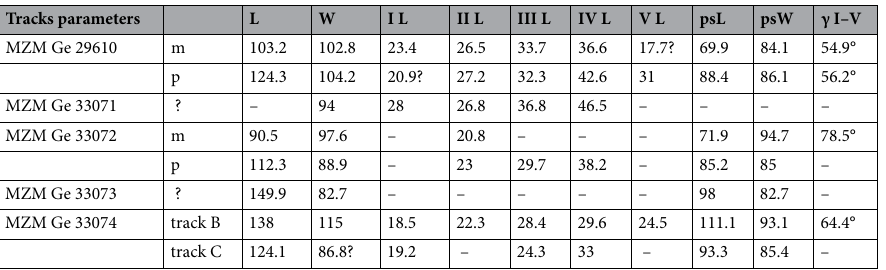
Table 1. Ichnological parameters of Dimetropus tracks. L length, m manus, p pes, psL palm/sole length, psW palm/sole width, W width, γ I–V interdigital angle I–V (°), I–V L length of digits I–V. Measurements in mm and